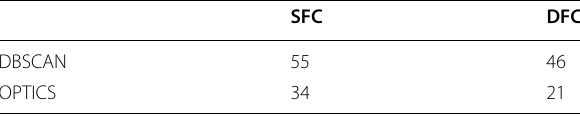
Lower value indicates better performance